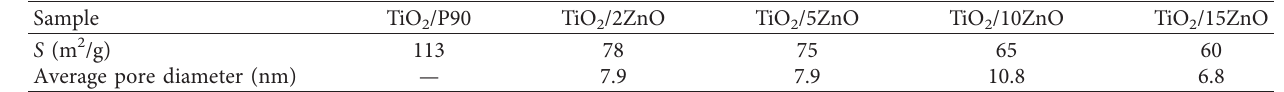
Figure 4: Pore size distribution of TiO 2 /P90 and TiO 2 /ZnO nanocomposites. Table 2: Structural and adsorption characteristics of TiO 2 /ZnO